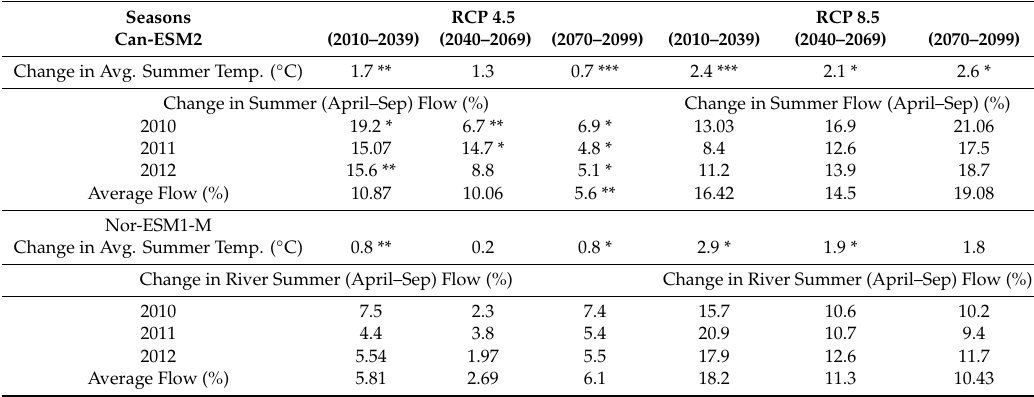
Table 5. Future flows prediction under climate change scenarios